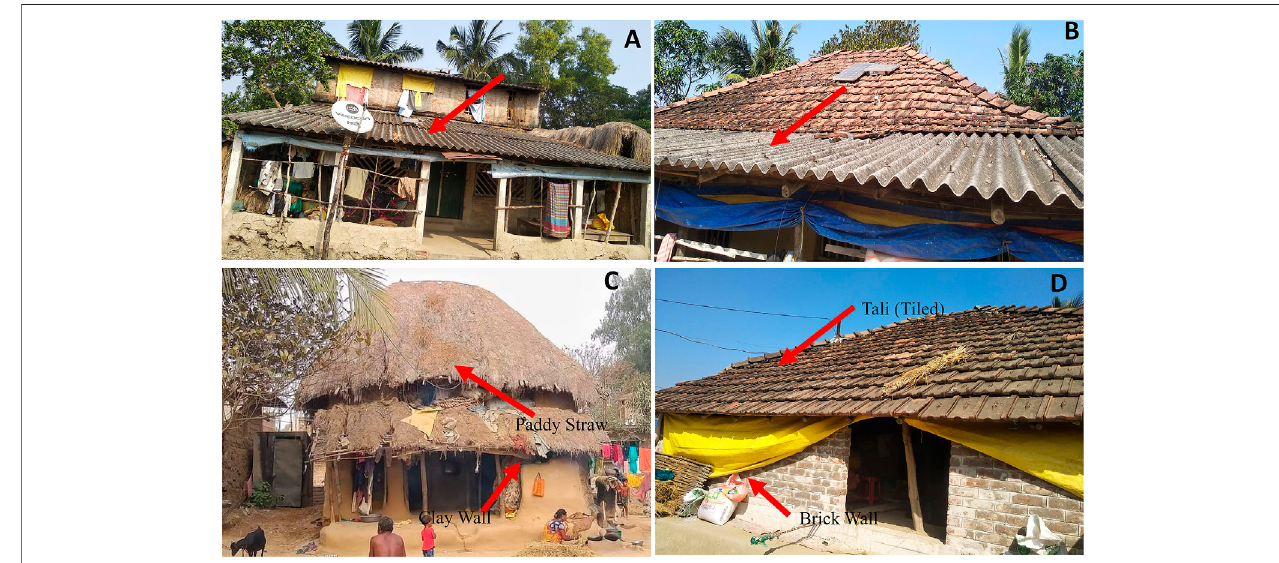
FIGURE 11 | Sun shading window (A,B) ; building materials used (C,D)